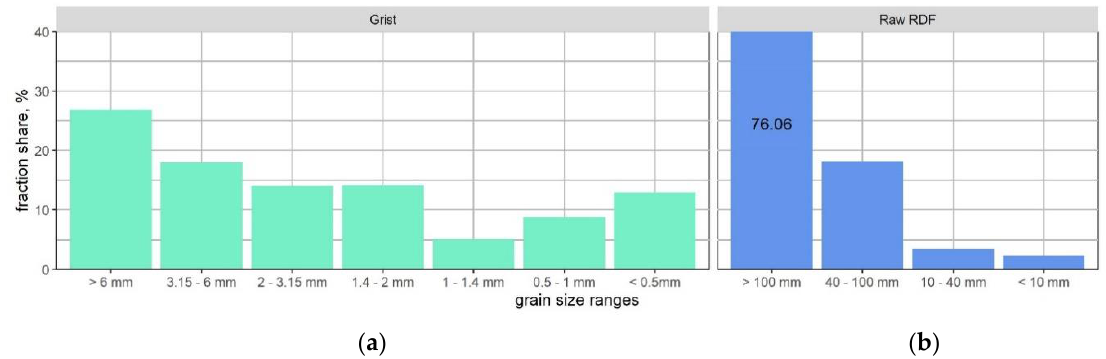
Figure 8. Comparison of RDF grain size distribution after milling ( a ), and before ( b ).